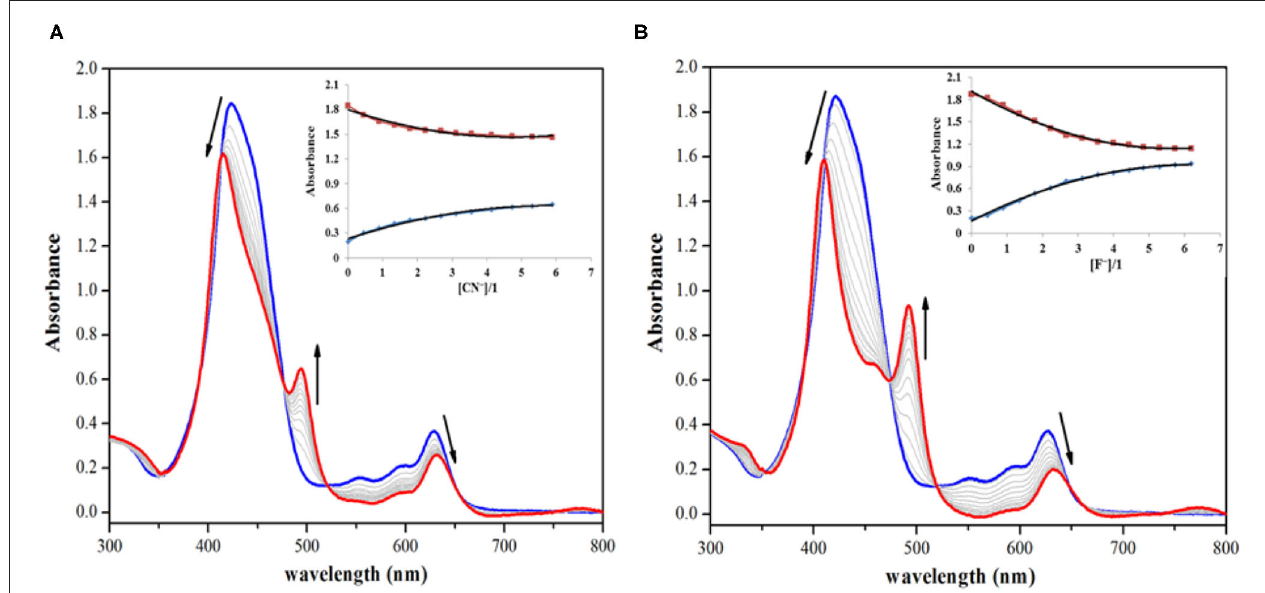
FIGURE 2 | Absorption spectral titrations of 1 on addition of (A) 0–1.56 × 10 − 4 M, 7 equiv. of CN − ions and (B) 0–1.56 × 10 − 4 M, 7 equiv. of F − ions in distilled CH 2 Cl 2 at 298K. Insets show decreasing absorbance at 424nm and the collateral increasing absorbance at 493nm against [anion conc./ 1